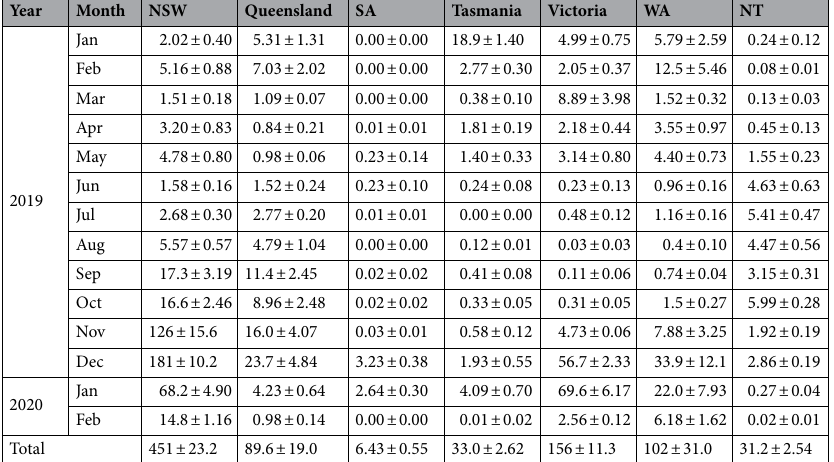
Table 2. Monthly time series of estimated CO 2 emissions (Tg CO 2 month −1 ) in six states and one territory between January 2019 and February 2020. The values show the average and one standard deviation of the eight results from a combination of input